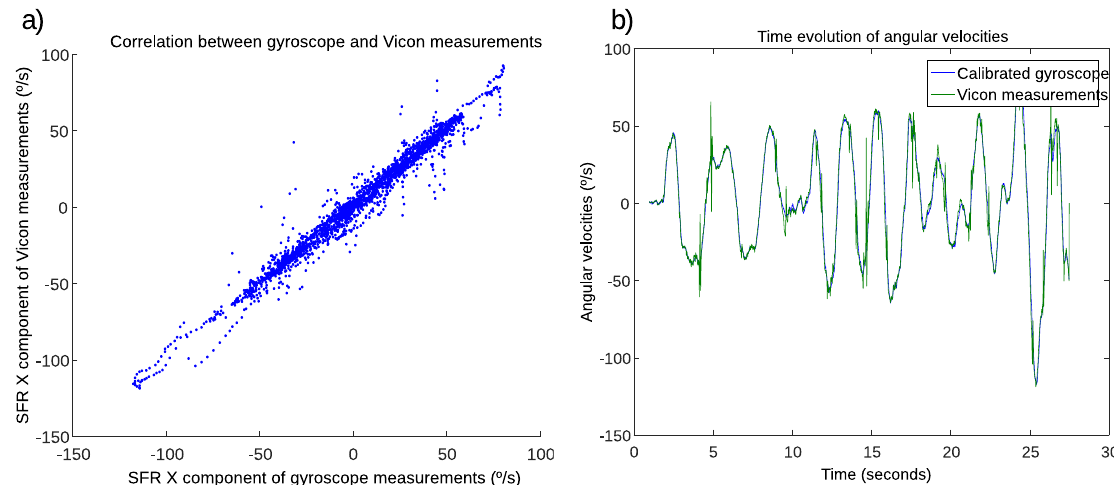
Figure 6. Validation of the measurements of the x component of the gyroscope. ( a ) Correlation between gyroscope and motion capture system (MCS) measurements. ( b ) Evolution of angular velocity measurements. SFR, sensors’ frame of